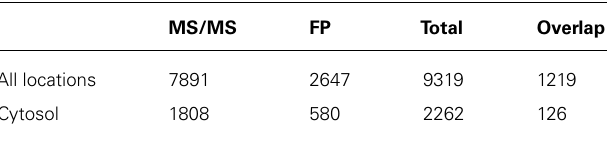
MS/MS indicates proteins identified through subcellular proteomics studies; FP are proteins localized using a fluorescent protein tag. The overlap between FP and MS/MS for cytosolic proteins is significantly worse than all proteins localized in the SUBA database. Possibly reflecting poor attention to this subcellular space and its processes by the research